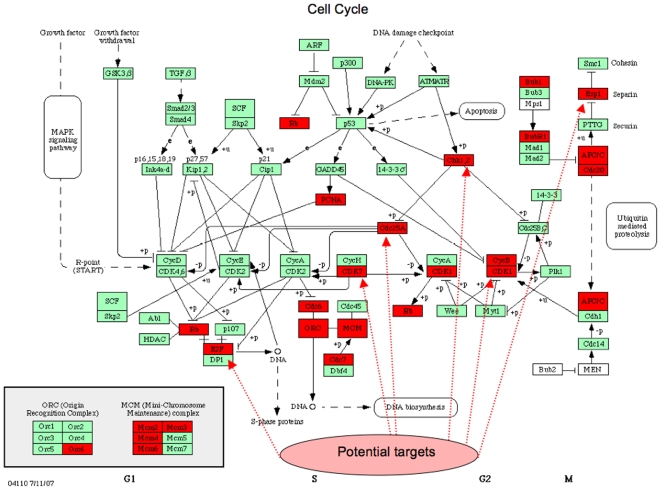
Differentially overexpressed genes in tumour (red boxes) depicted in the Cell Cycle map from KEGG PATHWAYS (Kanehisa et al., 2008) (P<0.05).21 of 21 cell cycle genes were overexpressed in mesothelioma versus normal parietal pleura tissue. Potential targets for anti-tumour treatment described in the litterature are marked (see text). Abbreviations: CDK7 = cyclin-dependent kinase 7, CHEK1 = checkpoint homolog, E2F2 = E2F transcription factor 2, ORC6L = origin recognition complex, subunit 6 like, MCM2-3-4-6 = minichromosome maintenance complex component 2-3-4-6, PCNA = proliferating cell nuclear antigen, RB1 = retinoblastoma, BUB1 = budding uninhibited by benzimidazoles 1 homolog, BUB1B = BUB1 beta, CDC7 = cell division cycle 7 homolog, APC/C = CDC23, cell division cycle 23 homolog, anaphase-promoting complex subunit 8, CCNB1 = cyclin B1, CCNB2 = cyclin B2, ESPL1 = extra spindle pole bodies homolog 1, CDC2/CDK1 = cell division cycle 2, G1 to S and G2 to M, CDC6 = cell division cycle 6 homolog, CDC20 = cell division cycle 20 homolog, CDC25A = cell division cycle 25 homolog A.